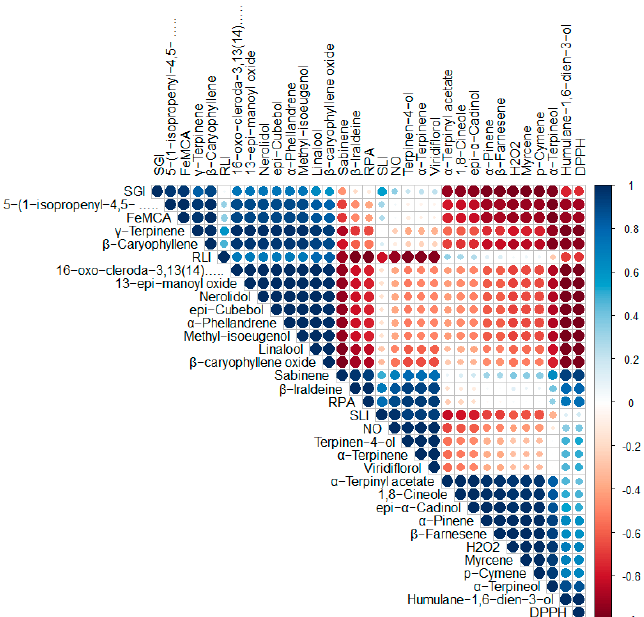
Figure 5. Correlation among chemical components of essential oils and biological activities of Vitex species (here, DPPH = percent inhibition of DPPH radical scavenging activity at 50 µL/mL; H 2 O 2 = percent inhibition of H 2 O 2 radical scavenging activity at 50 µL/mL; NO = percent inhibition of NO radical scavenging activity at 50 µL/mL; RPA = percent inhibition of reducing power activity at 50 µL/mL; FeMCA = percent inhibition of Fe 2+ metal chelating activity at 50 µL/mL; SGI = percent inhi- bition of seed germination at 100 µL/mL; RLI = percent inhibition of root length at 100 µL/mL; SLI = percent inhibition of shoot length at 100 µL/mL.